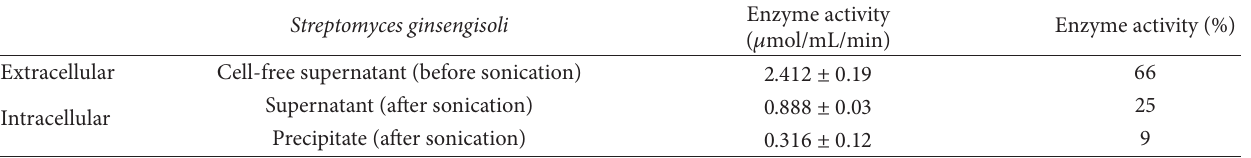
Table 2: 66% of the enzyme activity was found to be extracellular when compared with intracellular enzyme activity.